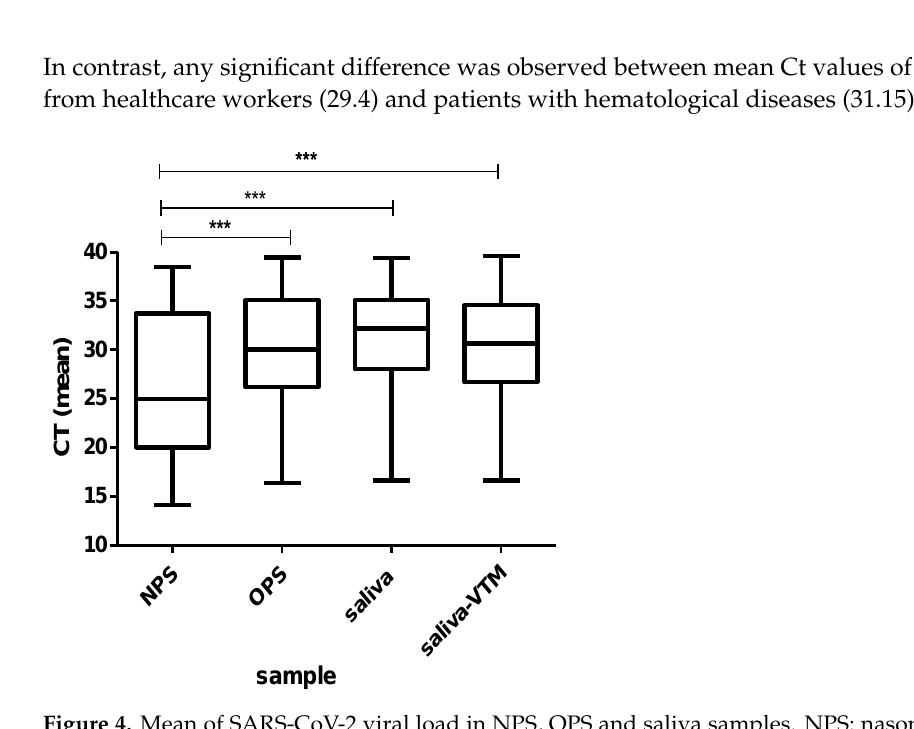
Figure 4. Mean of SARS-CoV-2 viral load in NPS, OPS and saliva samples. NPS: nasopharyngeal swab, OPS: oropharyngeal swab, saliva-VTM: saliva with viral transport medium. Ct: cycle threshold. *** p < 0.001.